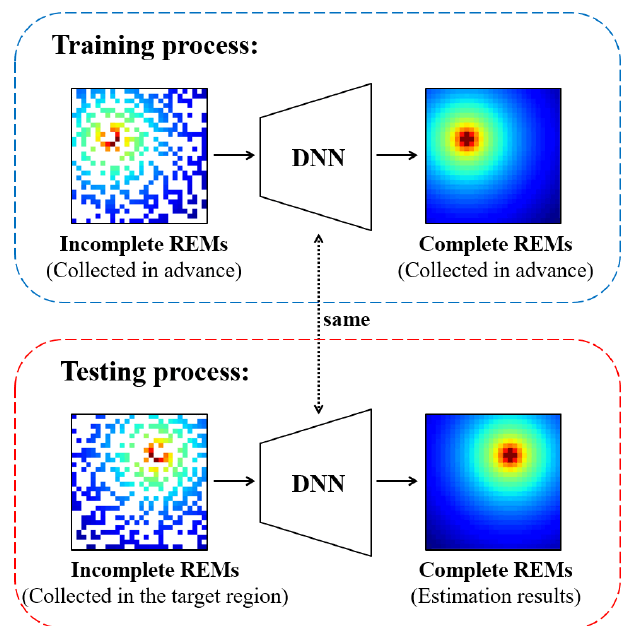
Figure 2. The sketch map of the MEGANs algorithm. The deep neural network (DNN) is trained to learn from the paired training data, i.e., the incomplete REMs and the complete REMs, to estimate the radio environment